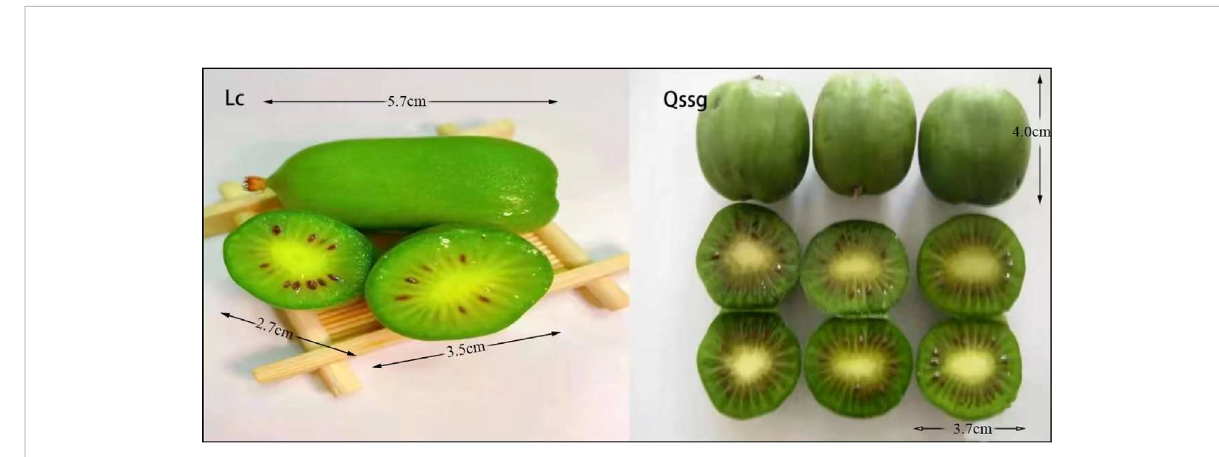
FIGURE 1 Qssg and Lc of two main cultivars of Actinidia arguta Sieb.Zucc .in Northern